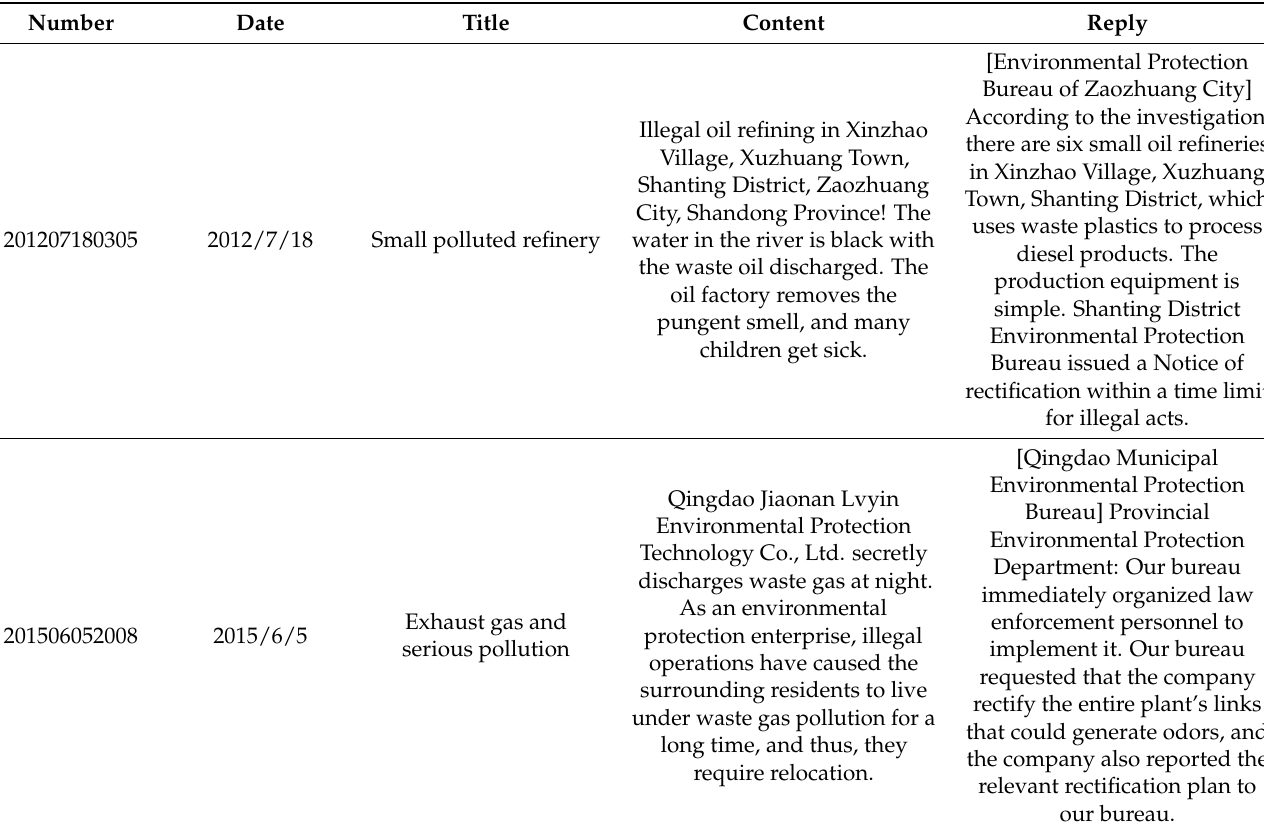
Table 1. Sample data of public complaints (Translate data into